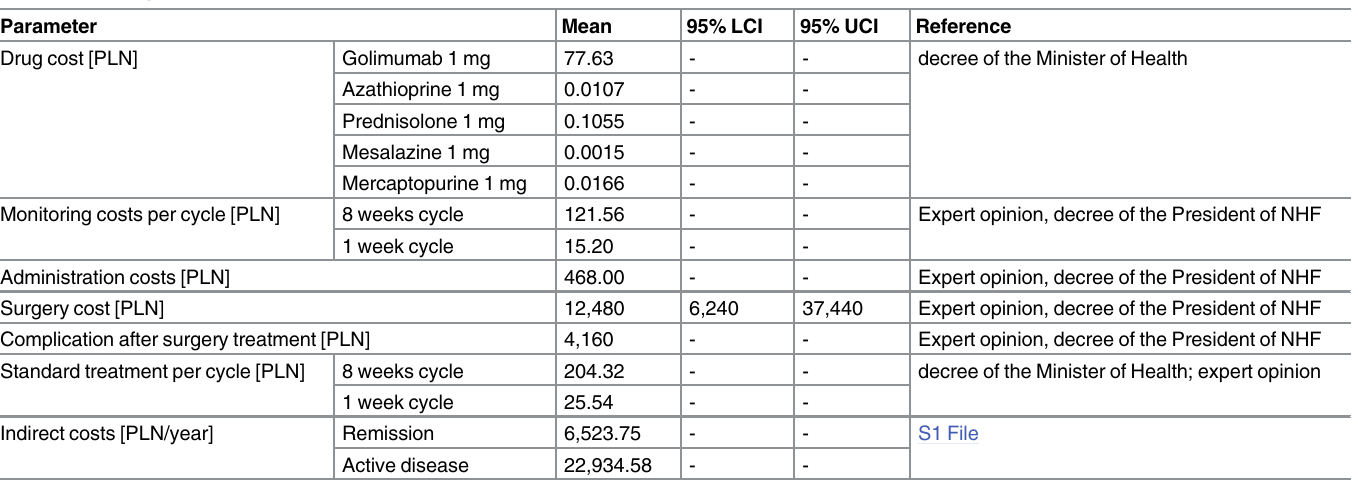
Table 2. Cost inputs used in the